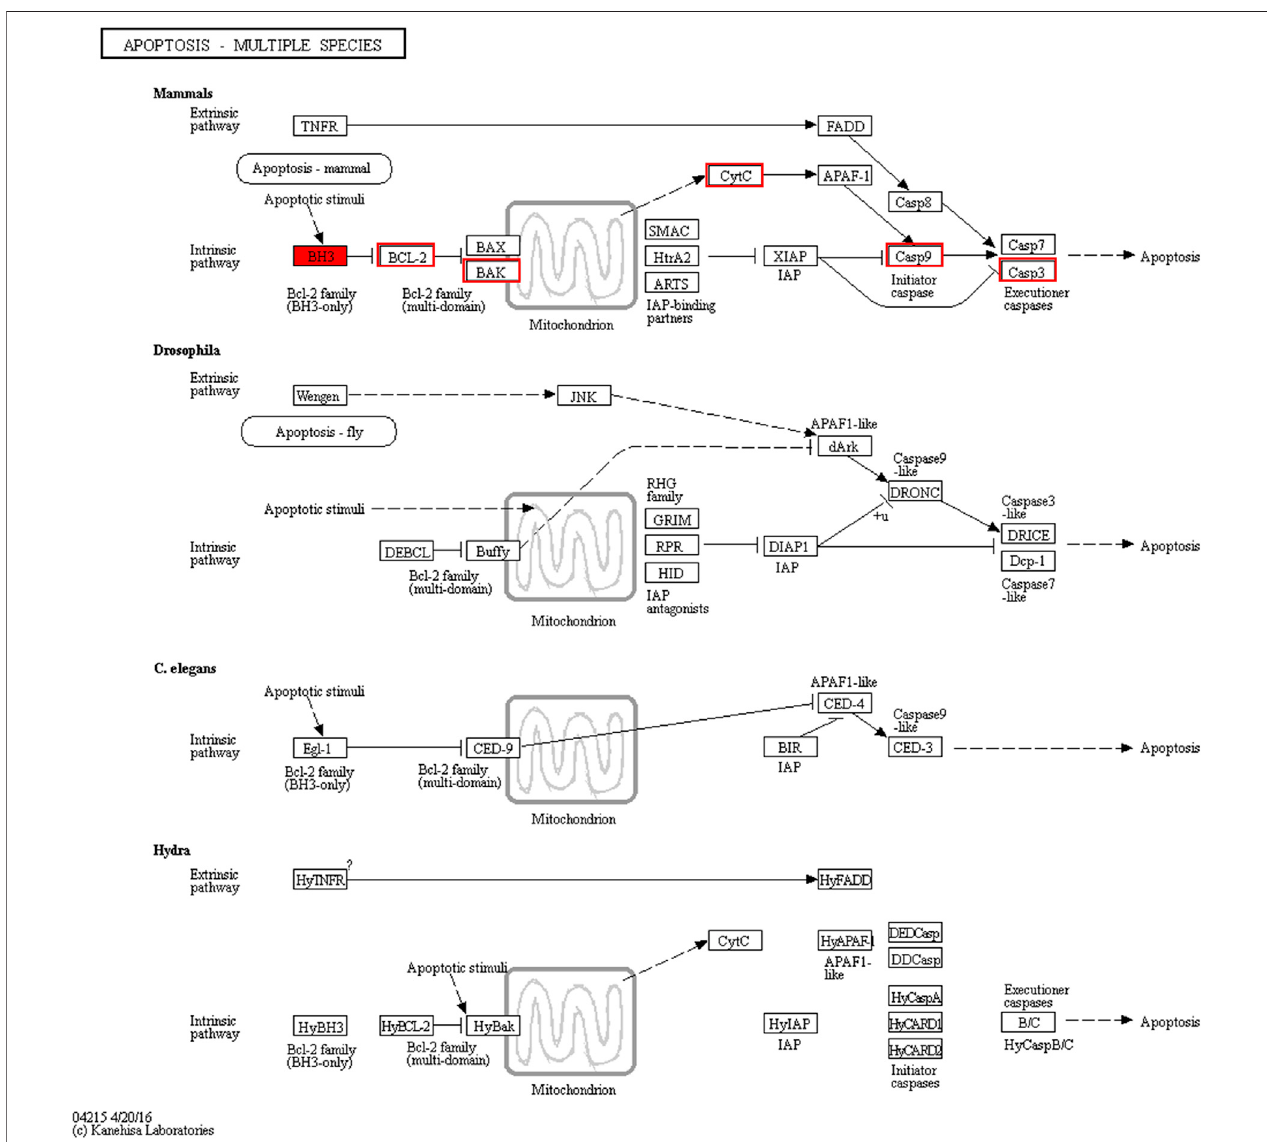
FIGURE 8 | “ Apoptosis-multiple species ”